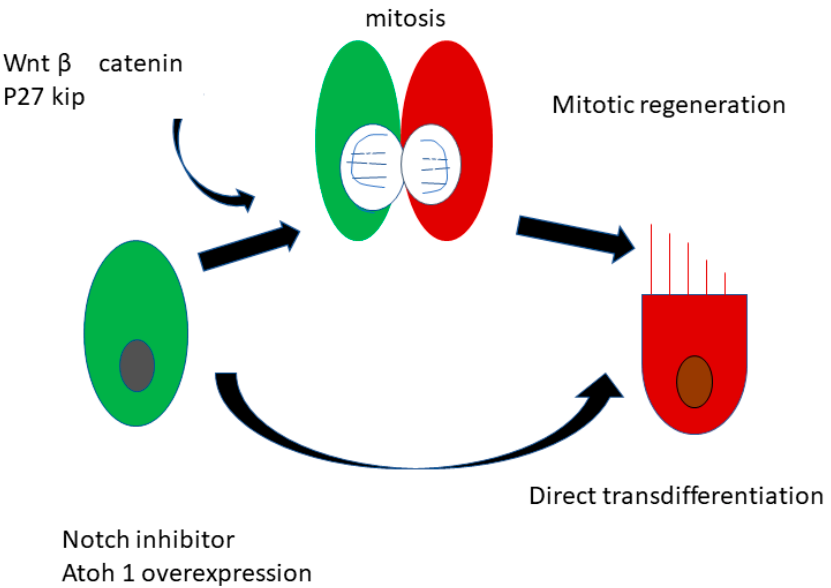
Figure 4. Schematic of the mechanisms underlying inner ear hair cell regeneration. There are two theories concerning hair cell regeneration: (1) direct of transdifferentiation from supporting cells (SCs) to new hair cells (HCs) (green), and (2) proliferation of SCs and mitotic regeneration (red).